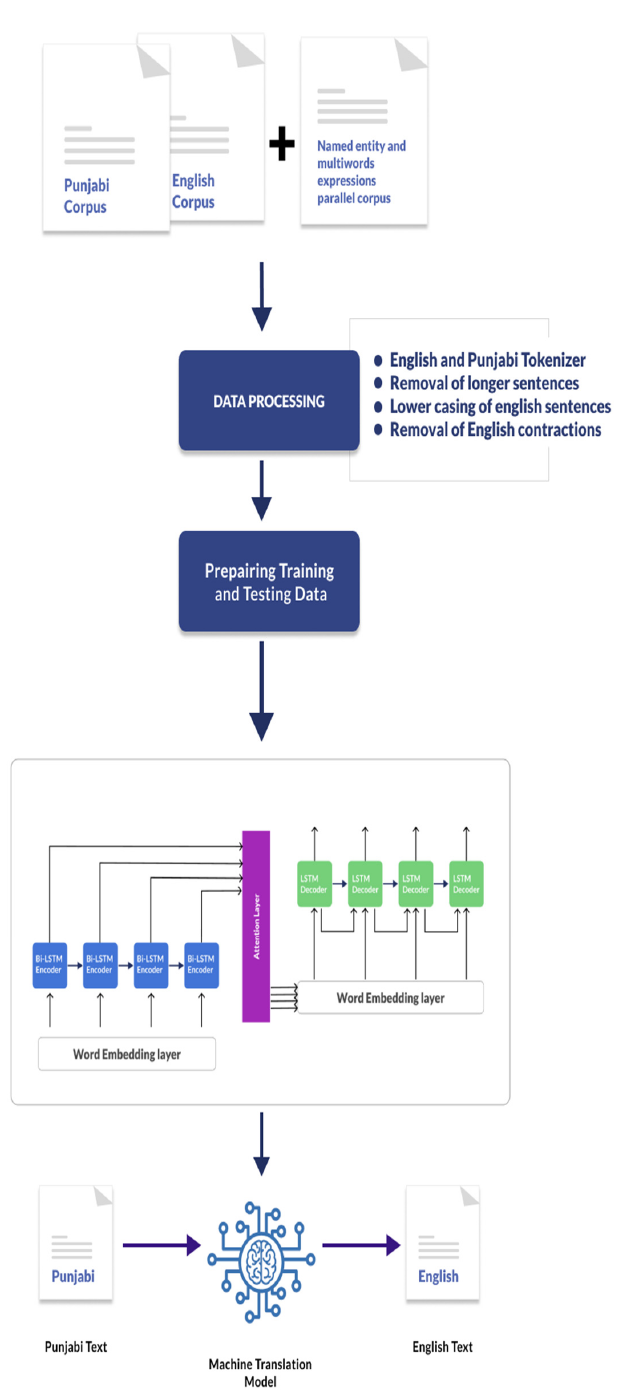
Figure 3. NMT model 4